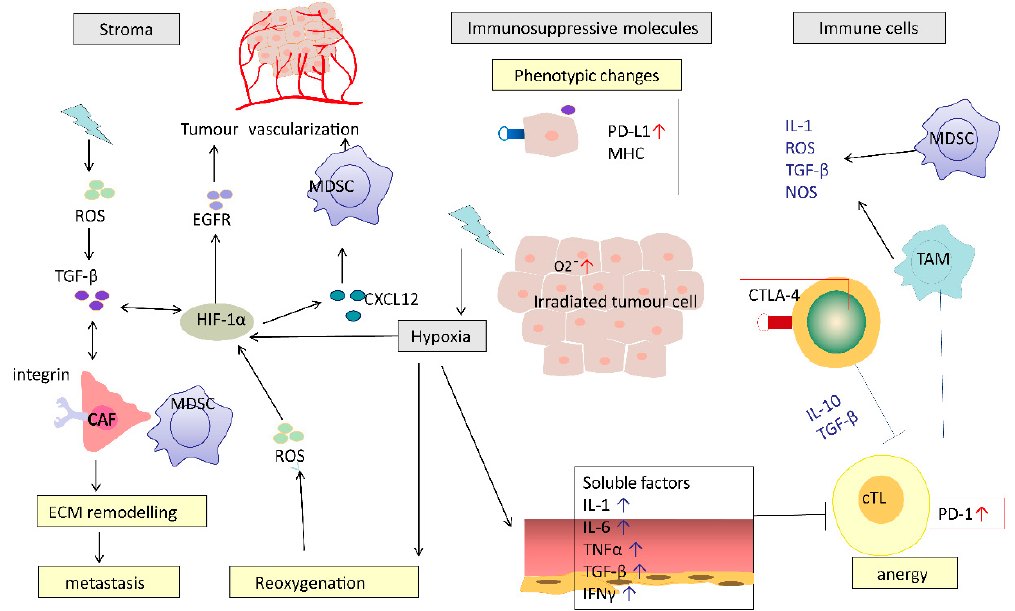
Figure 2. Potential mechanisms of RT-induced immunosuppression. RT causes a series of immunosuppressive processes: modifying tumour stromal environment, production of immunosuppressive molecules, recruiting immunosuppressive cells and impairing effective T cells. RT causes hypoxia, which induces HIF-1 α and TGF- β . HIF-1 α -activated CAFs mediated by TGF- β or directly by RT promote ECM re-modelling. These effects work in concert to promote cancer metastasis. CAF, cancer-associated fibroblasts; MDSC, myeloid-derived suppressor cell; cTL, cytotoxic T lymphocyte; TAM, tumour-associated macrophages; ECM, extracellular matrix; HIF-1 α , hypoxia-inducible factor-1 α ; TGF- β , transforming growth factor beta .